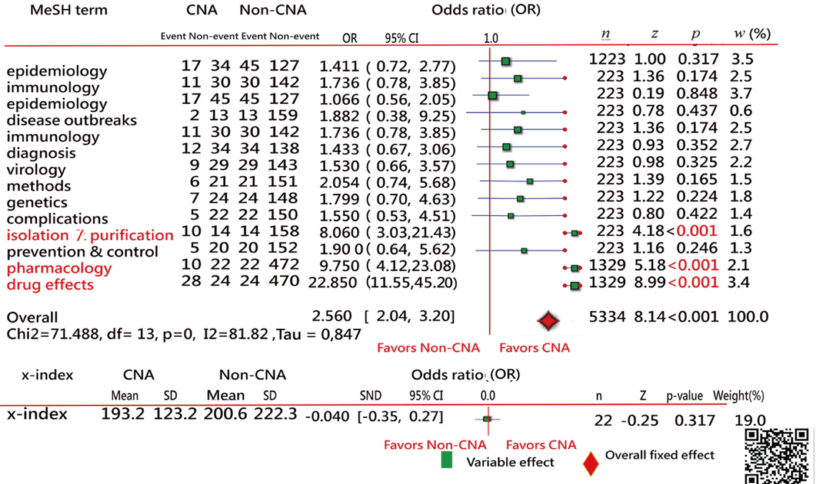
Figure 6. Comparison of features in the two samples of CNA and Non-CNA resulting in a forest plot; only three MeSH terms (in red) with different proportions ( p < 0.05) on count events and non-events were found in articles between the two collections based on the T100DO